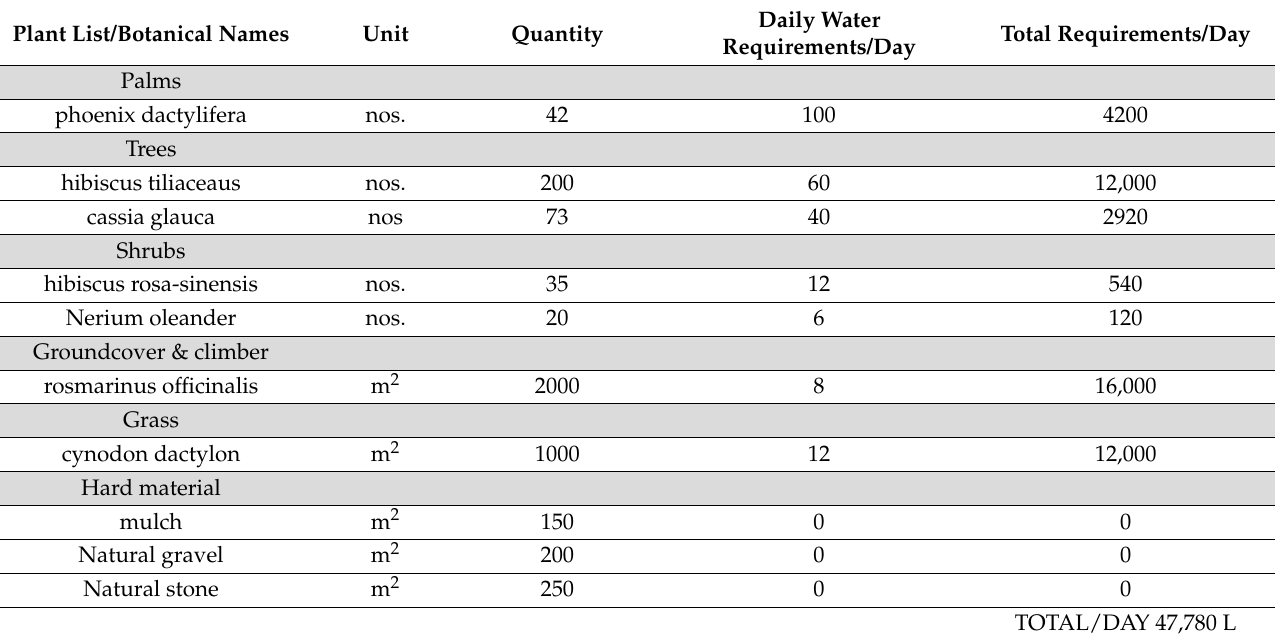
Table A7. Water consumption for each softscape item: Applying xeriscaping for GATE 11 landscape.